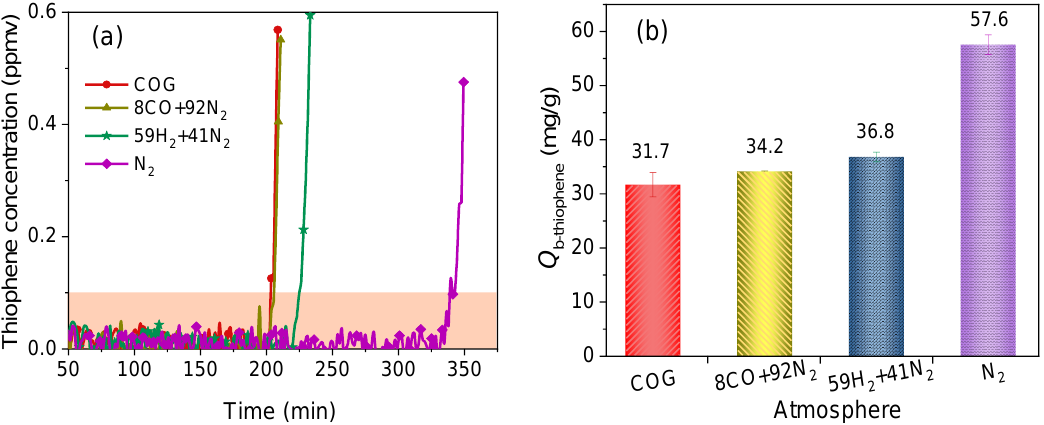
Figure 10. Thiophene breakthrough adsorption curves ( a ) and Q b-thiophene ( b ) of NaCeY in different desulfurization atmospheres at 200 °C.